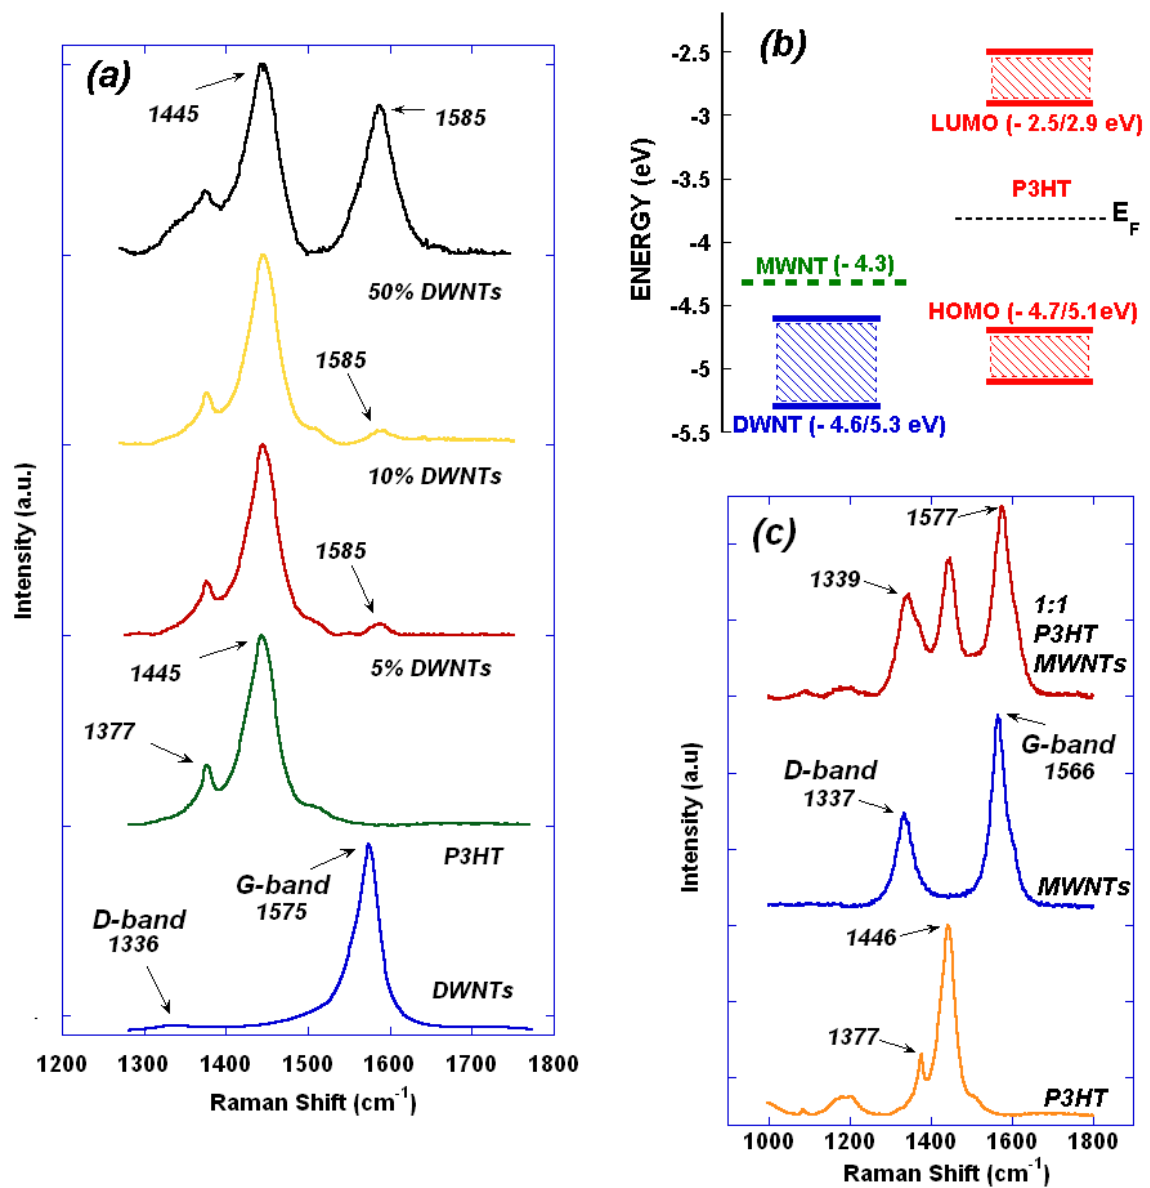
Figure 5. (a) Raman spectra of P3HT/DWNT compounds: (b) Energy band diagram of P3HT, DWNT Ref. [33] and MWNT Ref. [34]. (c) Raman spectra of P3HT/MWNT compunds w/w percentage